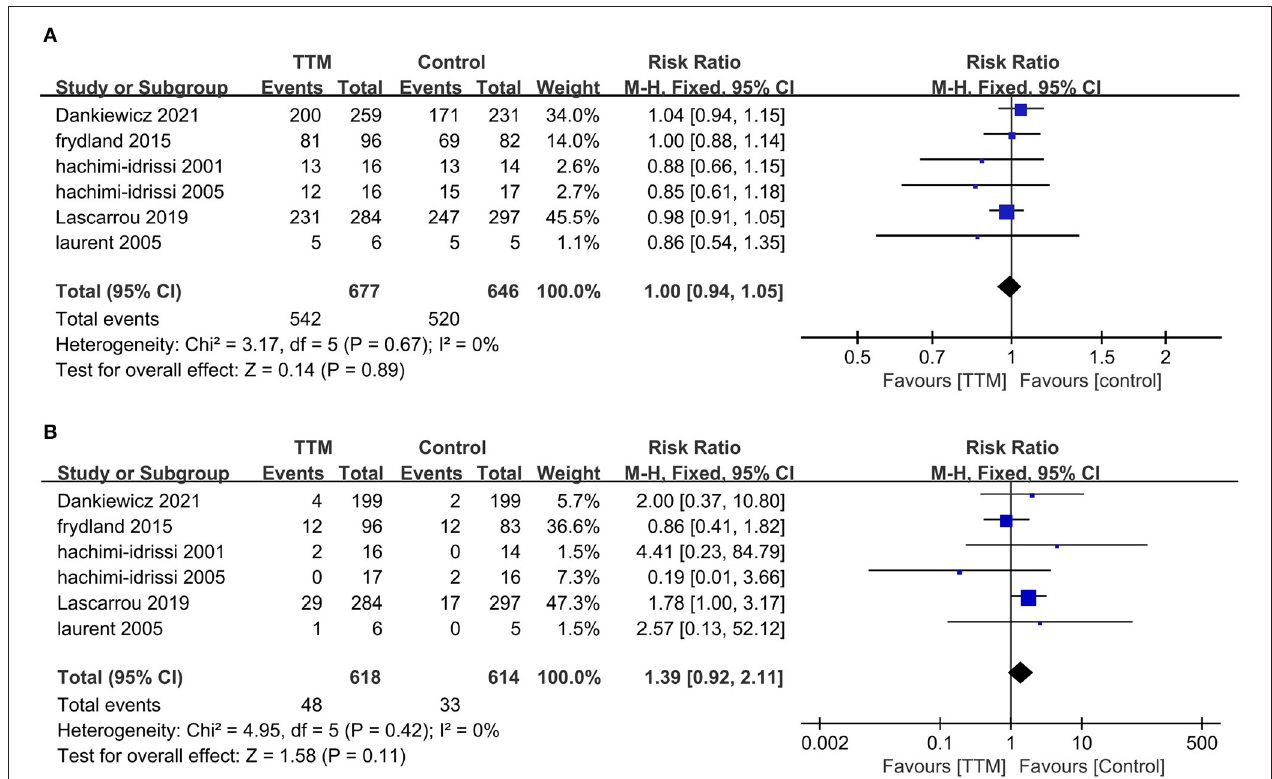
FIGURE 2 | Forest plot of the non-shockable rhythm survivors with or without targeted temperature management. (A) Mortality; (B) Good neurological